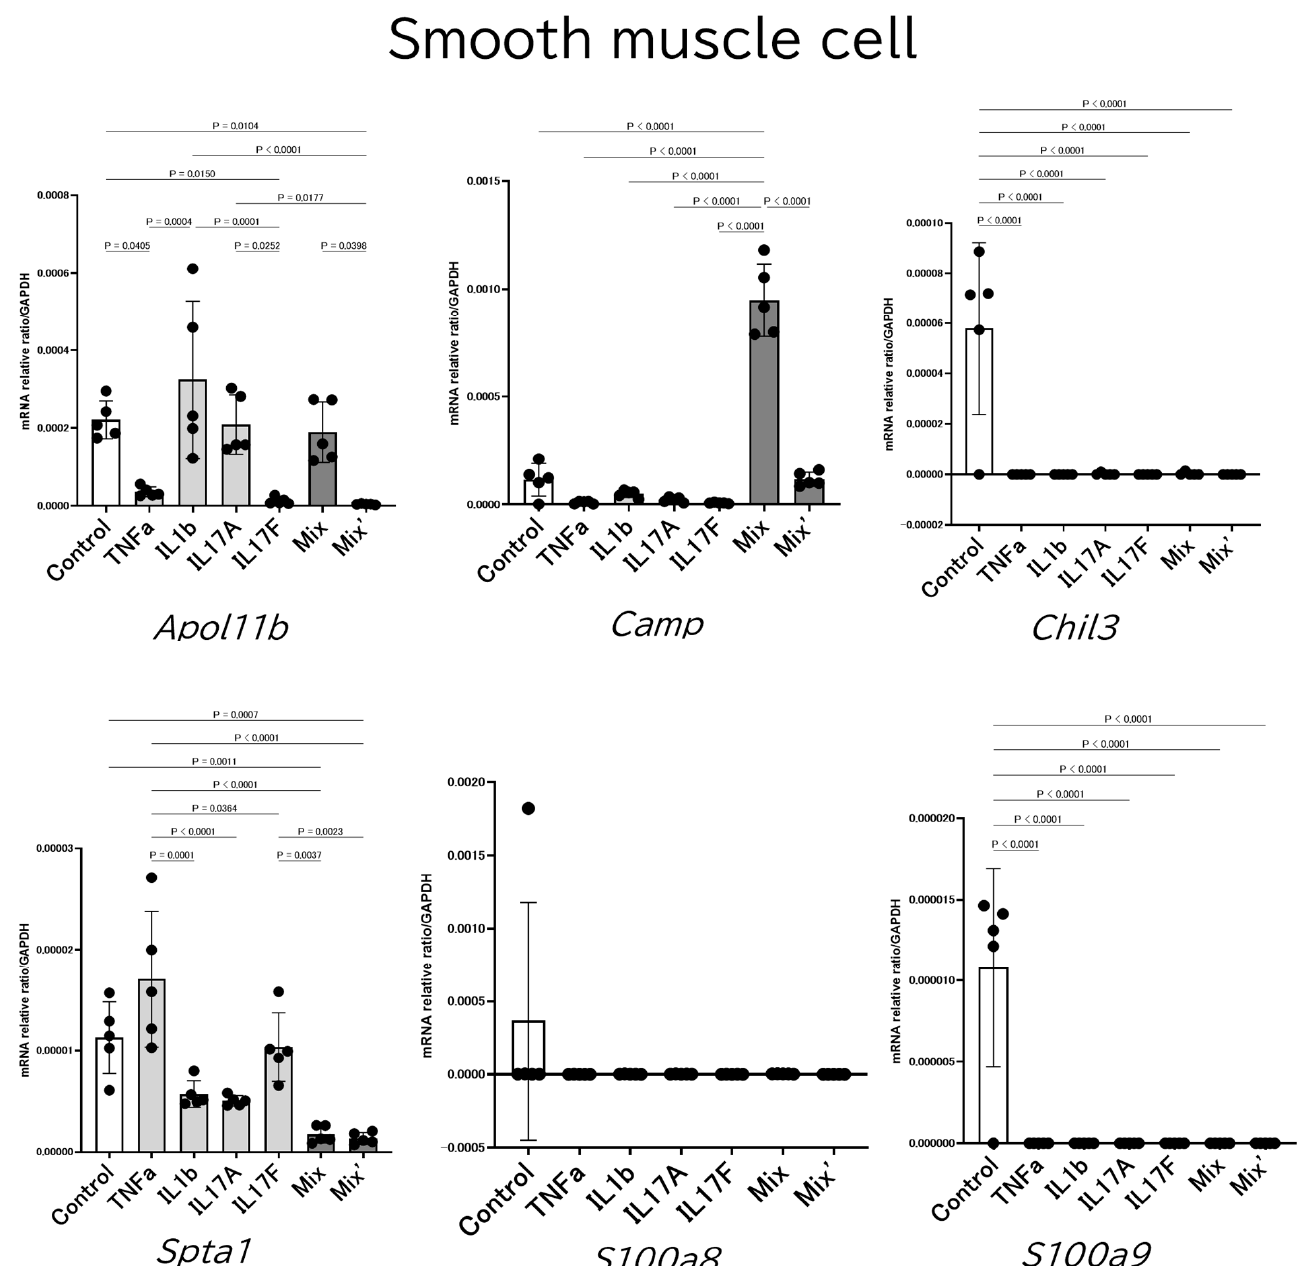
Figure 4. Culture of aorta-constituting cells. We measured the changes in mRNA expressions in the cultured endothelial cells, vascular smooth muscle cells, and fibroblast cells with inflammatory cytokines. The mRNAs for Camp , S100a8 , and S100a9 were significantly increased especially in the endothelial cell when co-cultured with the mixture of TNF- α , IL-1 β , or IL-17A/F. The culture systems of vascular smooth muscle cells and vascular fibroblasts did not provide constant and stable results. Mix = TNF- α , IL-1 β , IL-17A. Mix’ = TNF- α , IL-1 β , IL-17A, IL-17F. n = 5, each group. More than three groups were analyzed with the Ordinary one-way ANOVA followed by Tukey’s multiple comparison